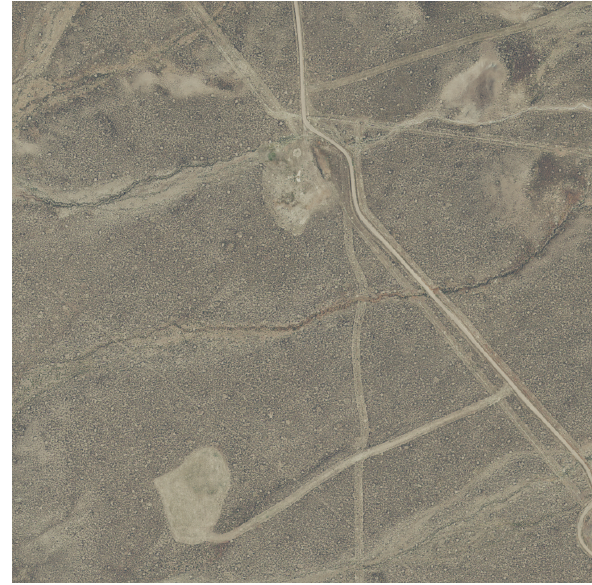
Figure 3. Model prediction on validation image from single oil pad set with 1 oil pad and rock structures.